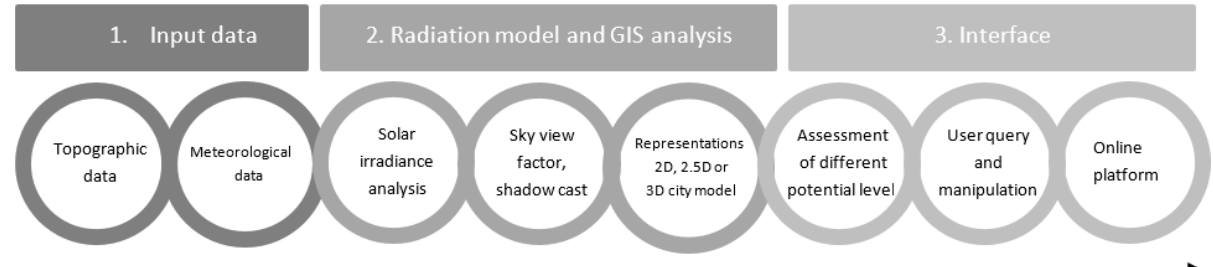
Figure 4. The sequential process to assess solar photovoltaic potential, adopted from (Freitas et al.,